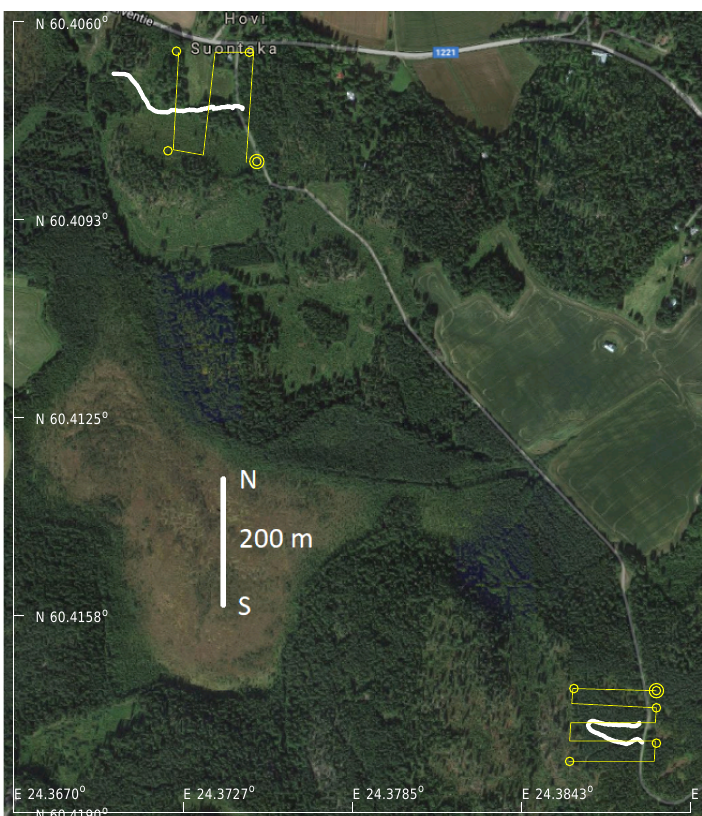
Figure 2. Trail 1 (below) and Trail 2 (above) are separated by approximately 1 km. The geo-reference markers are depicted by circles, the flight path is shown with the yellow cross-line and the trails by thick white curves. Trail 2 was not fully covered by the UAV photogrammetry. The starting points of the flight paths are indicated by the double